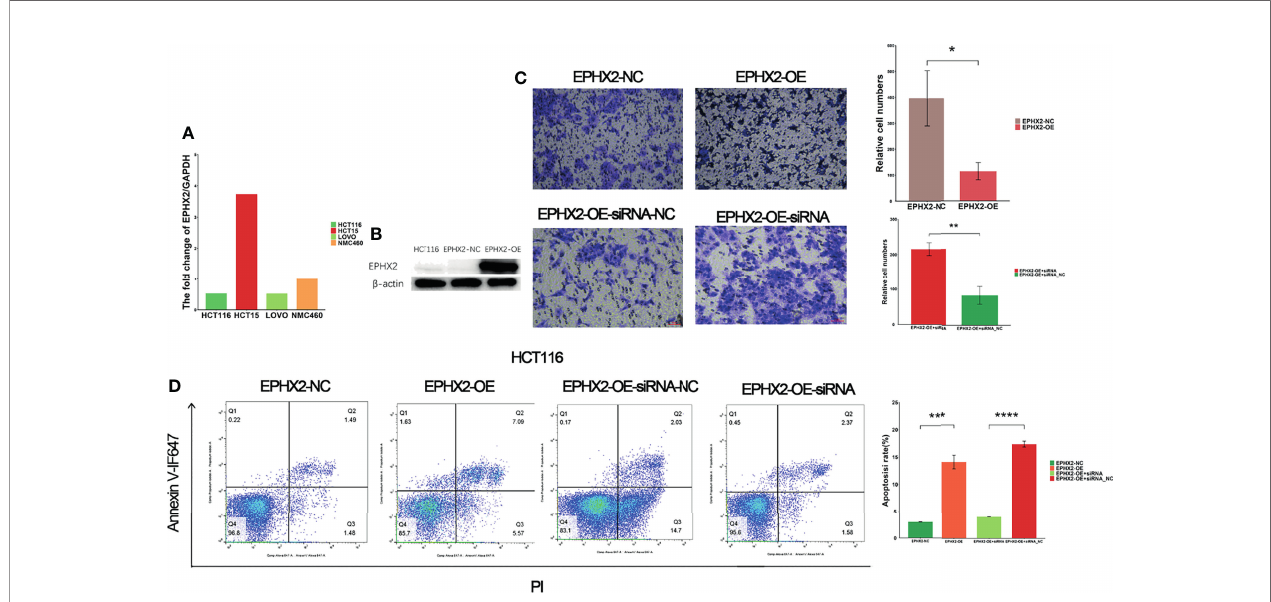
FIGURE 6 | EPHX2 low expression cell line screening, cell transfection, and phenotypic determination. (A) HCT116 cells with low background expression of EPHX2 were selected for stable overexpression of EPHX2. (B) Detection of WB after stable transfection of EPHX2 overexpression into HCT116. (C) Invasion in the EPHX2 overexpression HCT116 cells was inhibited, and this effect can be reversed by EPHX2-siRNA co-transfection. ANOVA was used to compare the mean values of relative cell numbers between the two groups. * p < 0.05, ** p < 0.01; original magni fi cation, 10×; scale bars, 50 m m. (D) Cell apoptosis was promoted in EPHX2 overexpression group, and co-transfection with siRNA can reverse this effect. Statistical signi fi cance was determined with ANOVA. *** p < 0.001, **** p < 0.0001.